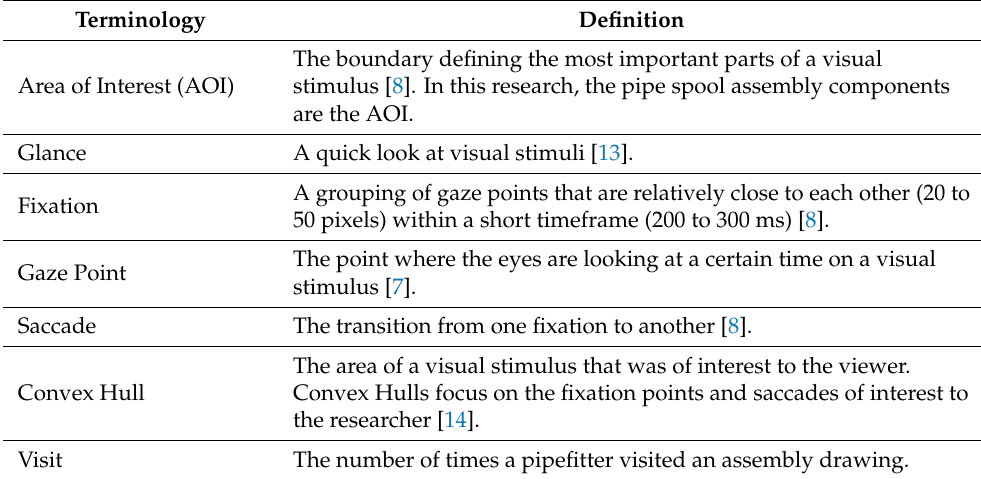
Table 1. Eye-tracking